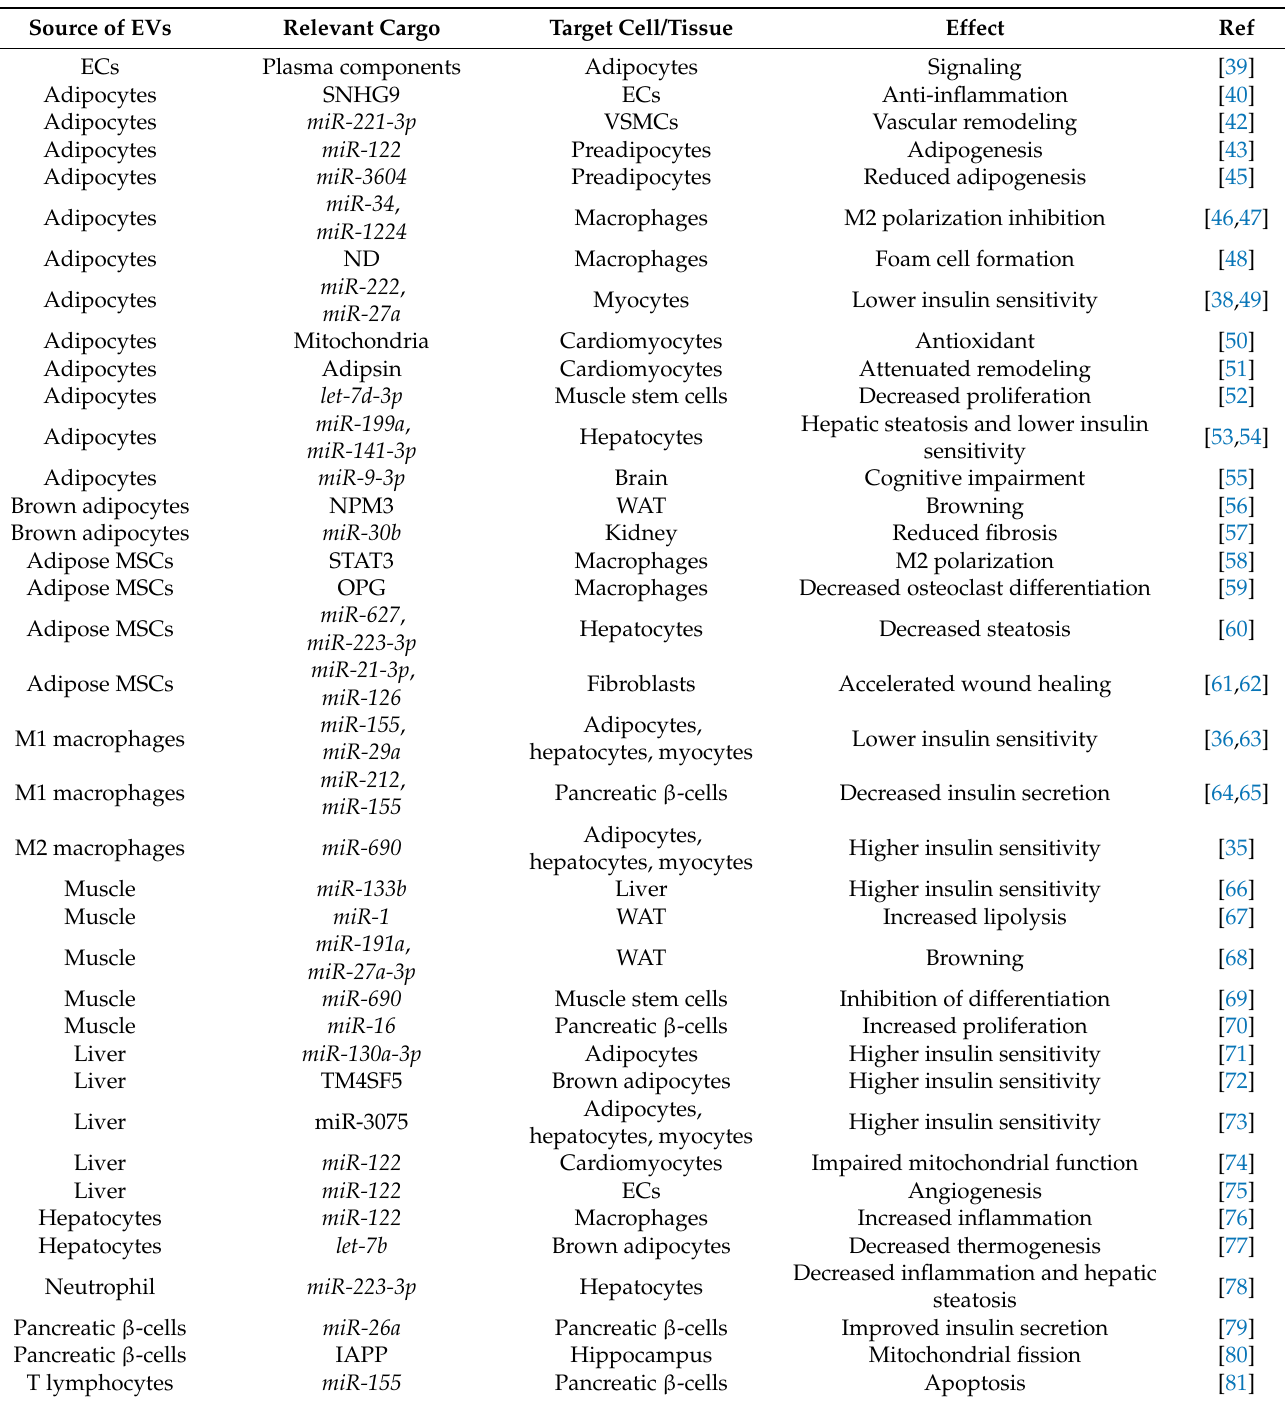
Table 1. Summary of the studies mentioned in the text dealing with EV-mediated inter-tissue communication. See text for